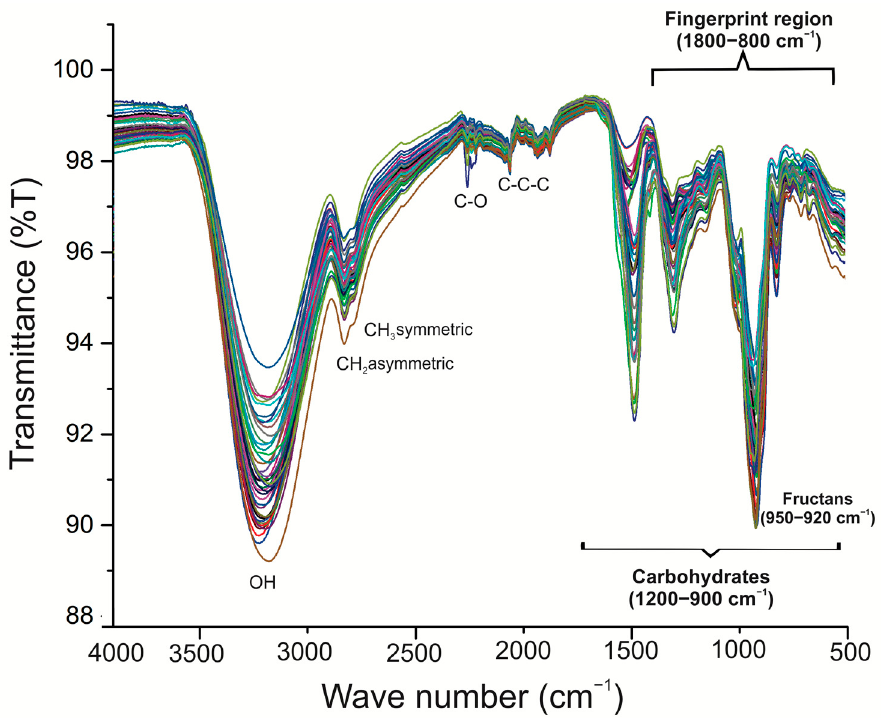
Figure 4. FT-IR full spectra of the agave fructans from A. angustifolia Haw. and A. potatorum Zucc. plants of different ages.